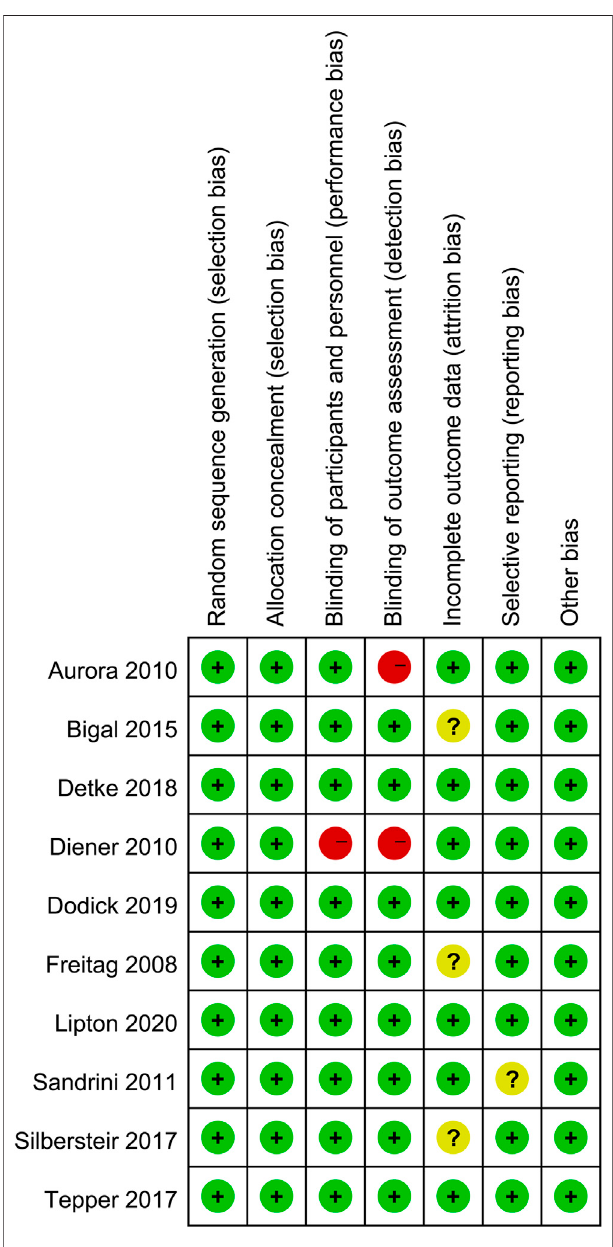
FIGURE 10 | Summary table for potential bias analysis for included